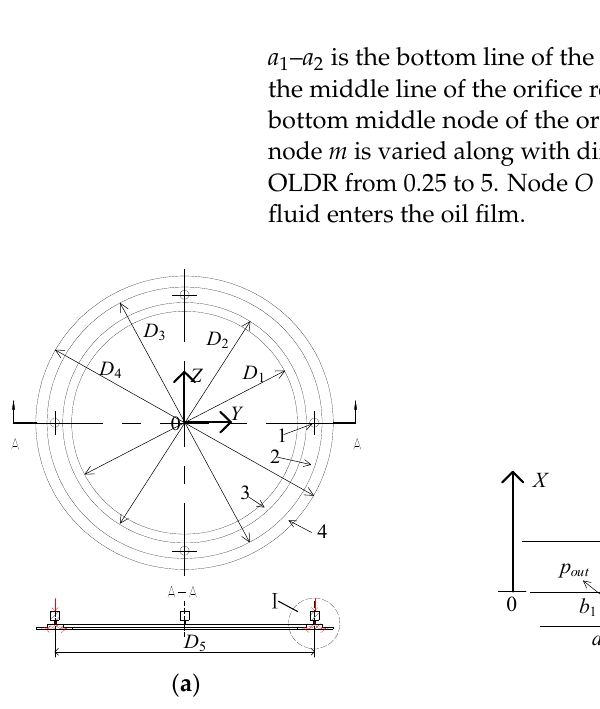
Figure 1. Schematic configuration of the orifice-compensated hydrostatic thrust bearing. ( a ) The hydrostatic thrust bearing; ( b ) local enlarged view of Ⅰ .